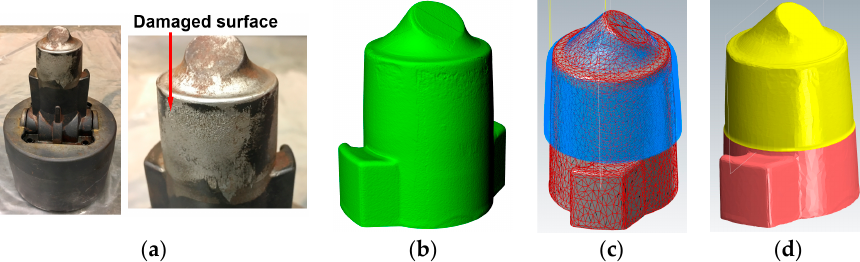
Figure 11. ( a ) A die with surface superficial defects; ( b ) STL model of the die; ( c ) machining toolpath; ( d ) model of the die after machining.